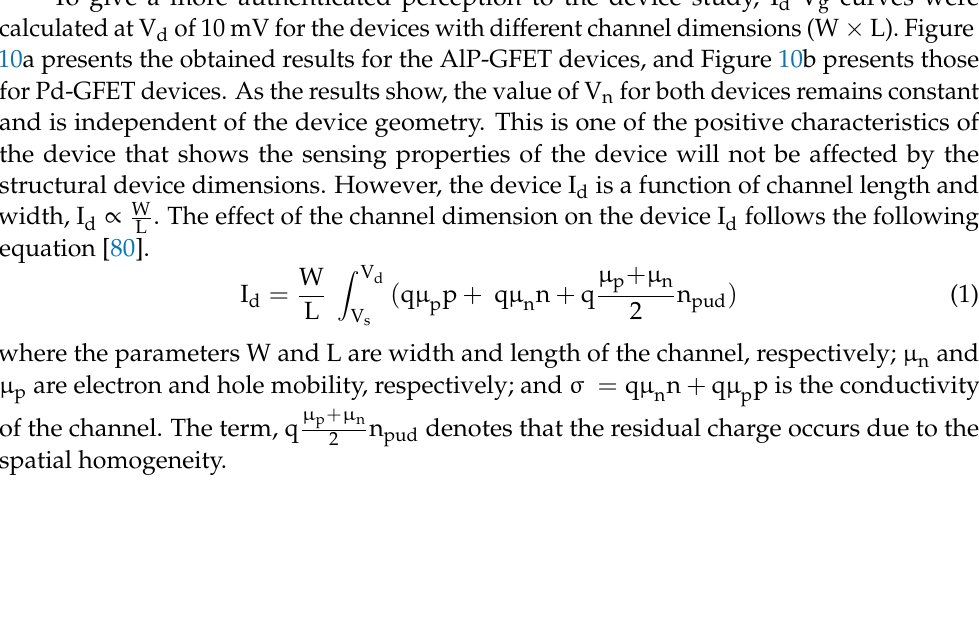
Figure 9. I–V characteristics as a function of applied V d for ( a ) Al-P doped GFET ( b ), Pd-decorated GFET. According to the graphs, V n of the devices remains constant as V d varies.